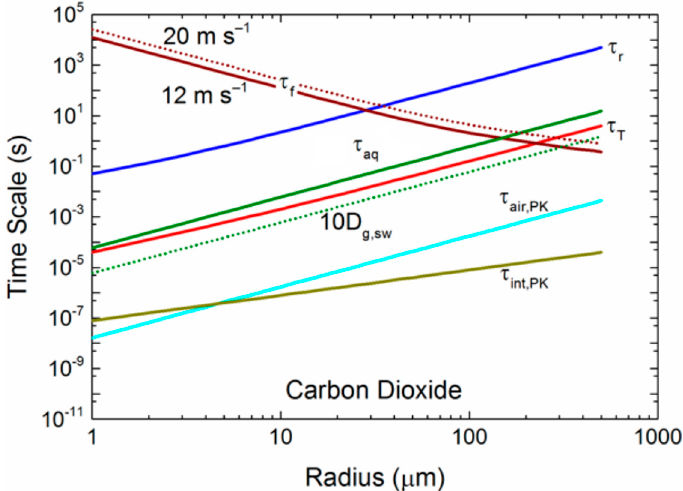
Figure 7. The dashed green curve gives τ aq when we increase the diffusivity within the droplets from 5 c to 10 D g,sw . The dashed τ f curve gives the residence time for a 10-m wind speed of 20 m s − 1 .